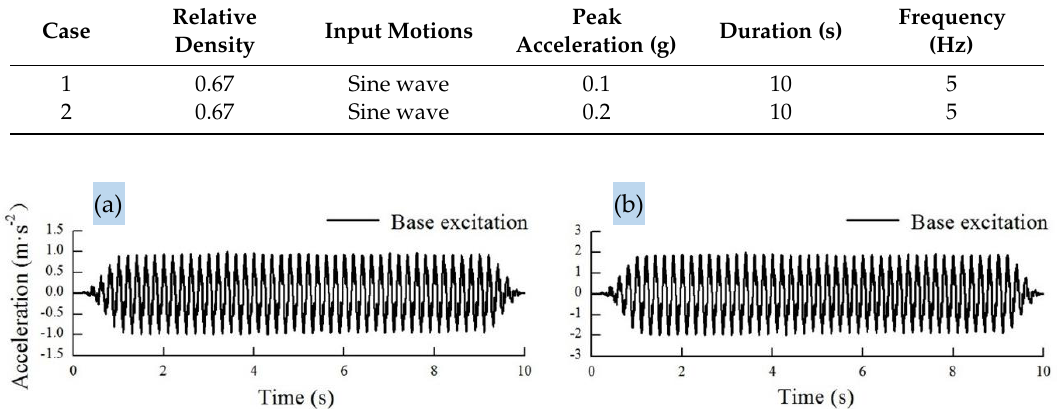
Figure 5. Time history curves of base excitation: ( a ) 0.1 g; and, ( b ) 0.2 g.